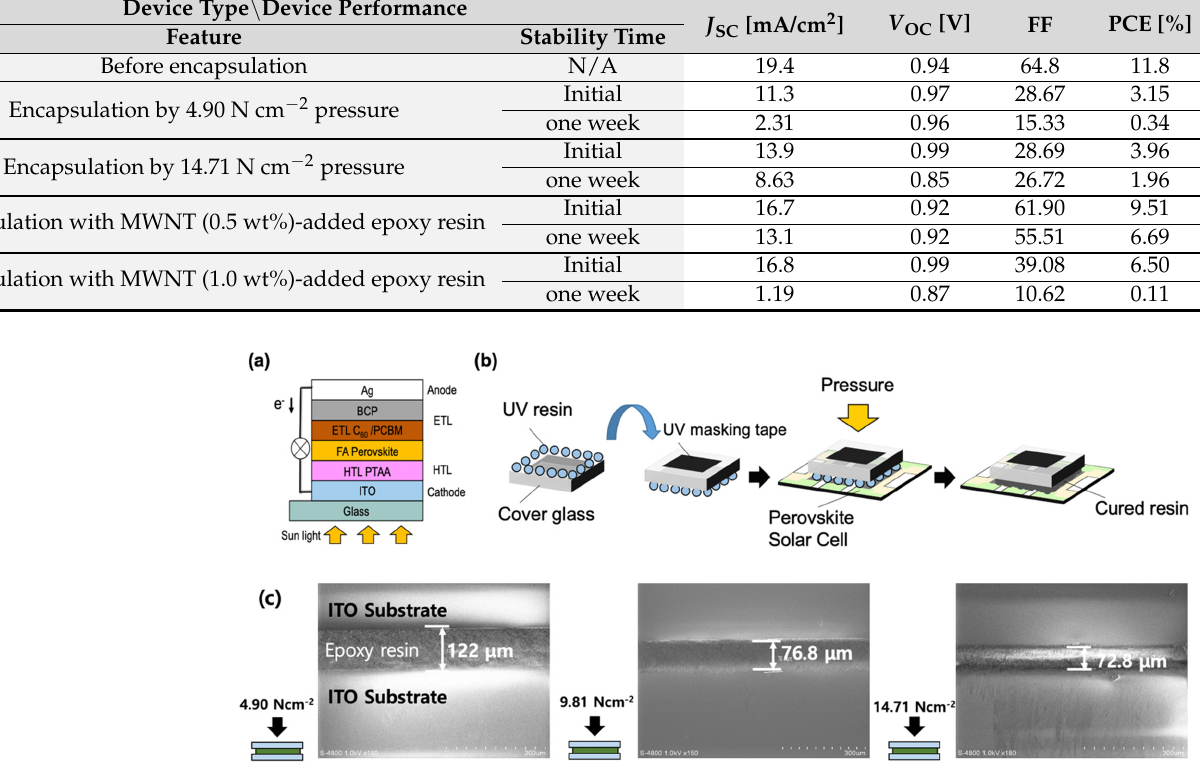
Figure 1. ( a ) Structure of an inverted PSC fabricated in this work; ( b ) packaging process using UV epoxy resin; ( c ) cross-sectional SEM images and thickness of the pressed UV-epoxy resin.